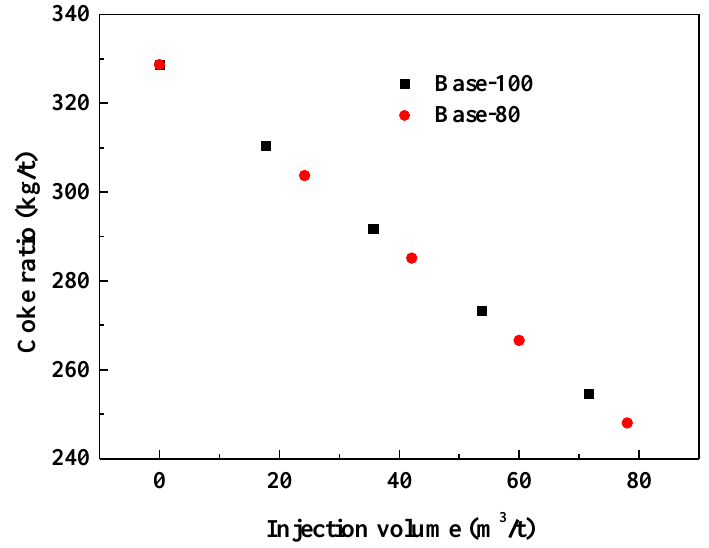
Figure 11. Coke ratio of blast furnace under different suitable gas injection volumes.